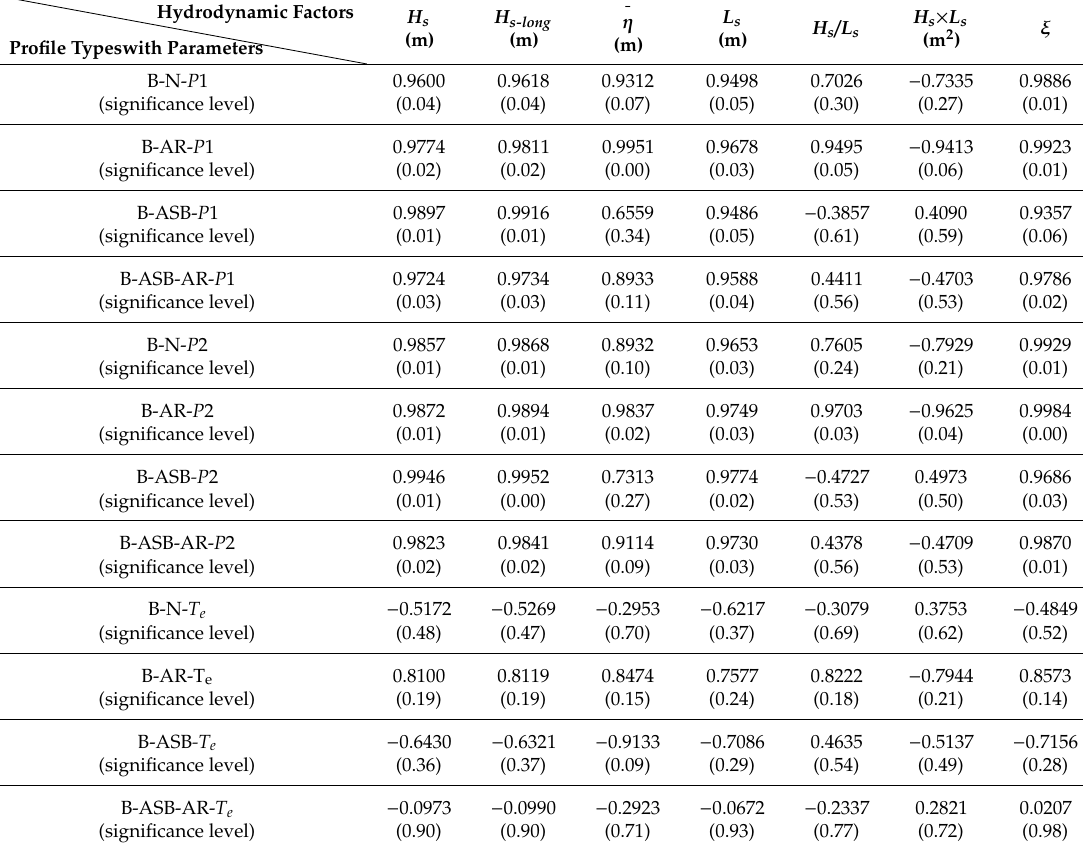
Table 5. Pearson correlation coe ffi cients and corresponding significance levels between fitting parameters of scarp model and hydrodynamic factors ( H s / L s and ξ are dimensionless factors).